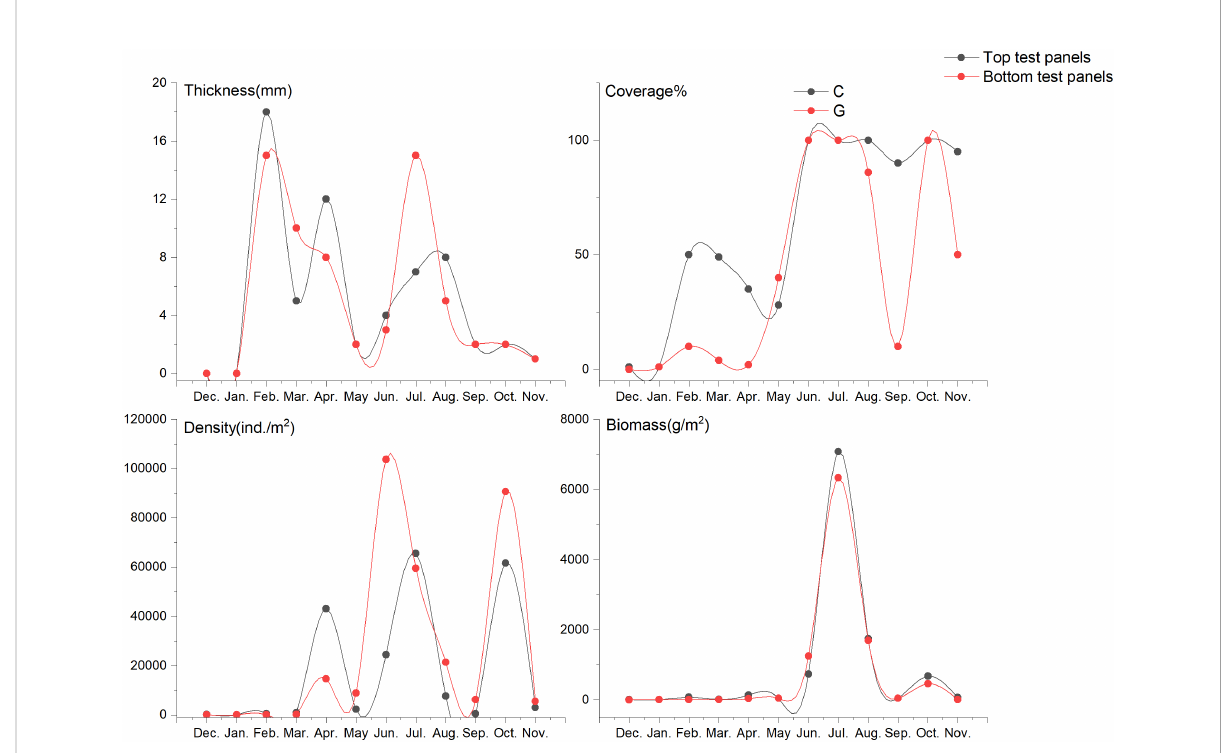
FIGURE 7 The attachment thickness, coverage, density and biomass of